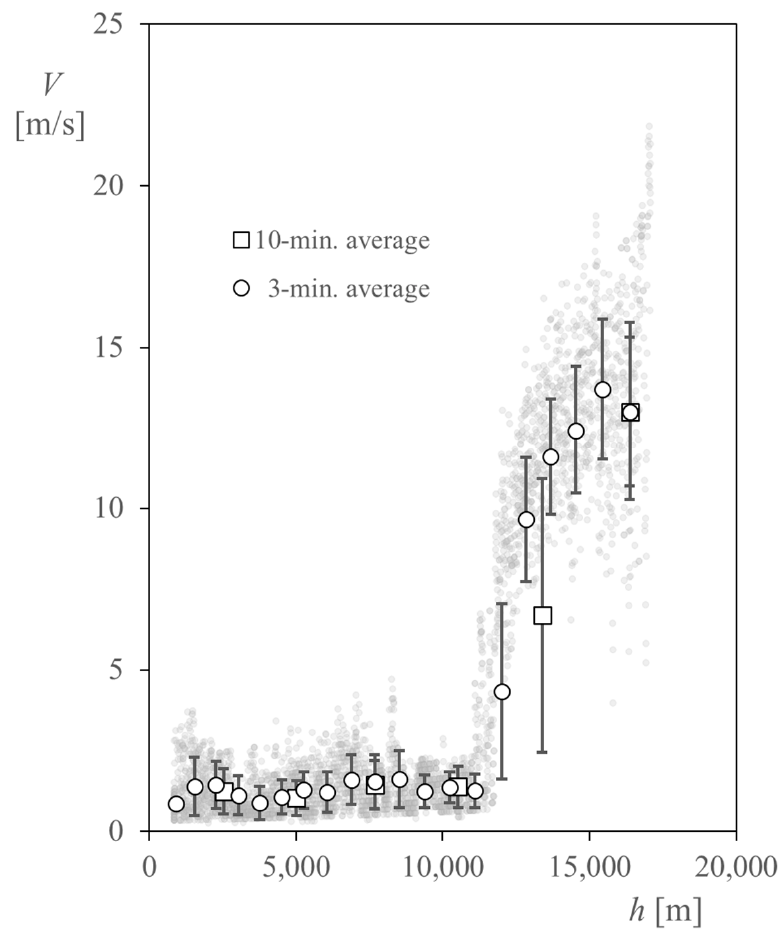
Figure 9. Horizontal wind speed measured by the cup anemometer, V , in relation to altitude, h , along the ascent phase of the TASEC ‐ Lab flight. The 3 ‐ min. and 10 ‐ min. average values (calculated before the corresponding altitude) have been included, together with the standard deviation bars (see also Tables 3 and 4).